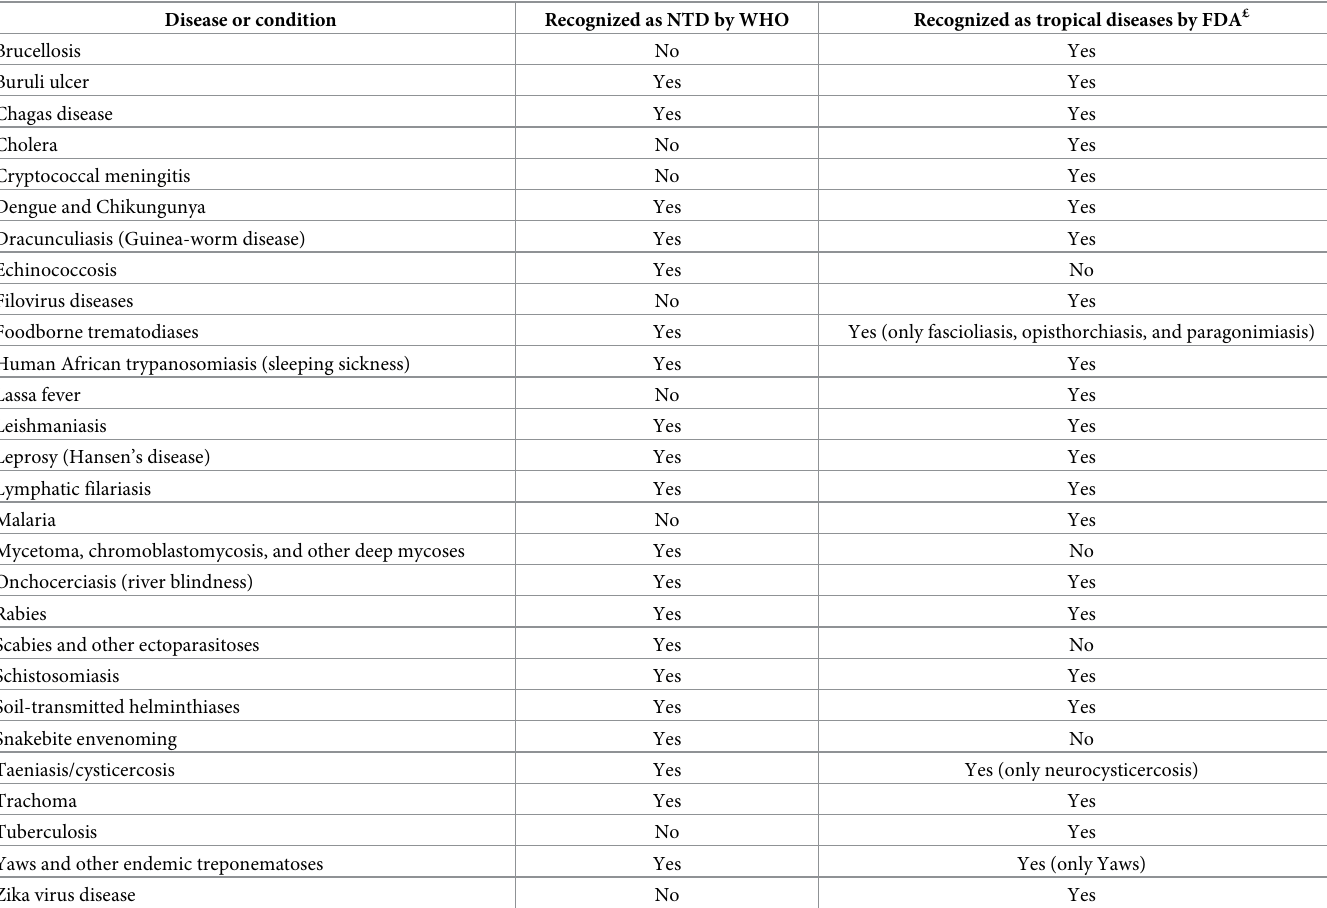
Table 1. List of diseases or conditions recognized by the WHO and US FDA as NTDs and tropical diseases, respectively. Disease or